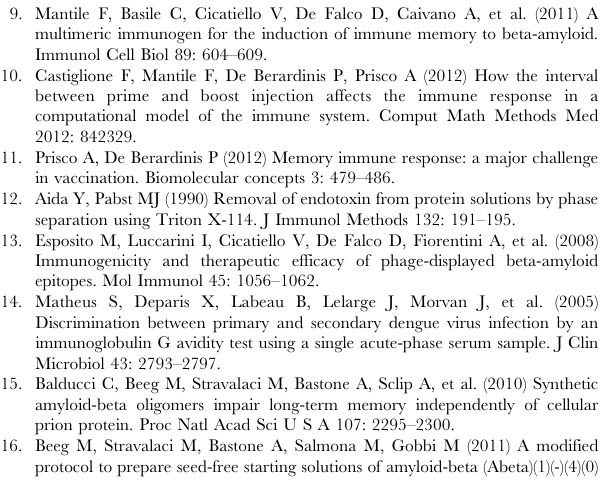
Figure S1 Titration curves of secondary anti-IgG1 and anti-IgG2a antibodies. The graph shows the absorbance of ELISA wells coated with IgG1 (clone BAM-10) and IgG2a (clone NAB-228) antibodies and incubated respectively with secondary anti-mouse IgG1 (black symbols) or anti-mouse IgG2a (open symbols). The x-axis error bars report the percentage error in replicate measures of the concentration of primary antibody, the y- axis error bars report the standard deviation in the absorbance of replicate wells. At the same concentration of primary antibody, wells incubated with anti-mouse IgG1 and anti-mouse IgG2a secondary antibodies show no significant difference of absorbance. (TIF) Figure S2 Isotype of anti-A b antibodies induced by LPS- free (1–11)E2 in individual mouse sera. panel a The histograms show the measured light absorbance in ELISA wells coated with A b and incubated with the sera from five mice (ALF1, ALF2, ALF3, ALF4, ALF5) vaccinated with LPS-free (1–11)E2 in Alhydrogel 2%. Sera were collected at day 109, and tested at 1:8000 dilution. Anti-A b antibodies were measured using secondary antibodies specific for IgG1 (open bars) or IgG2a (black bars). Histogram bars represent the mean absorbance of replicate wells, the error bars represent the standard deviation. IgG1 antibodies were more abundant than IgG2a in 4/5 mice. panel b The histograms show the measured light absorbance in ELISA wells coated with A b and incubated with the sera from four mice (SLF2, SLF3, SLF4, SLF5) vaccinated with LPS-free (1– 11)E2 in AddaVax. Sera were collected at day 109, and tested at 1:2000 dilution. Anti-A b antibodies were measured using secondary antibodies specific for IgG1 (open bars) or IgG2a (black bars). Histogram bars represent the mean absorbance of replicate wells, the error bars represent the standard deviation. IgG1 antibodies were more abundant than IgG2a in 4/4 mice. panel c The histograms show the measured light absorbance in ELISA wells coated with A b peptide Abeta(1–11) and incubated with the sera from five mice (PLF1, PLF2, PLF3, PLF4, PLF5), vaccinated with LPS-free (1–11)E2. Sera were collected at day 35, and tested at 1:2000 dilution. Anti-A b antibodies were measured using secondary antibodies specific for IgG1 (open bars) or IgG2a (black bars). Histogram bars represent the mean absorbance of replicate wells, the error bars represent the standard deviation. IgG1 antibodies were more abundant than IgG2a in 4/5 mice.